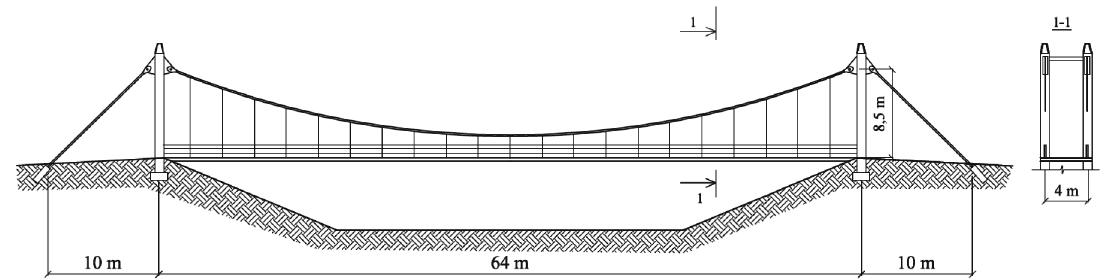
Fig. 1. General layout of a suspension